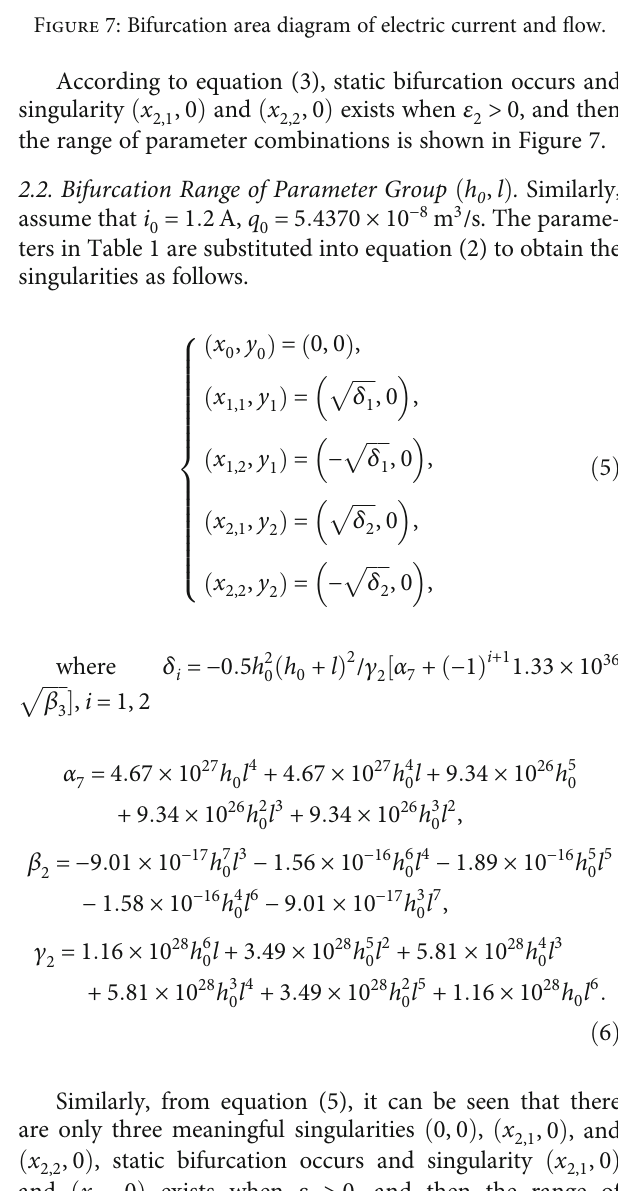
i q 1,1 , 0 , and 0 .